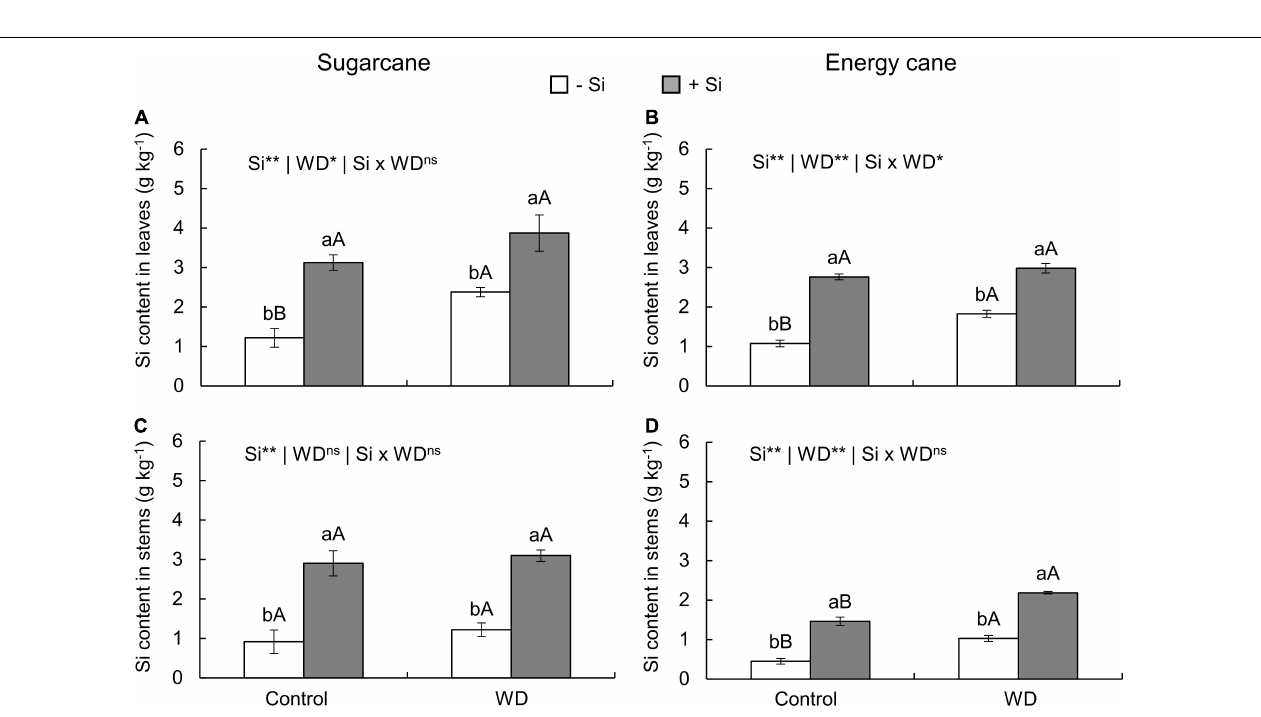
FIGURE 2 | Silicon contents in the leaves and stems of sugarcane (A,C) and energy cane (B,D) plants in -Si, and with + Si under adequate water regime (control) and in WD for a period of 7 to 160 days after transplanting. ** and * significant with 1 and 5% probability, respectively, and ns, not significant by the F -test. Lowercase letters indicate differences in relation to Si and capital letters in relation to water deficit. n = 5. Si × WD: interaction.